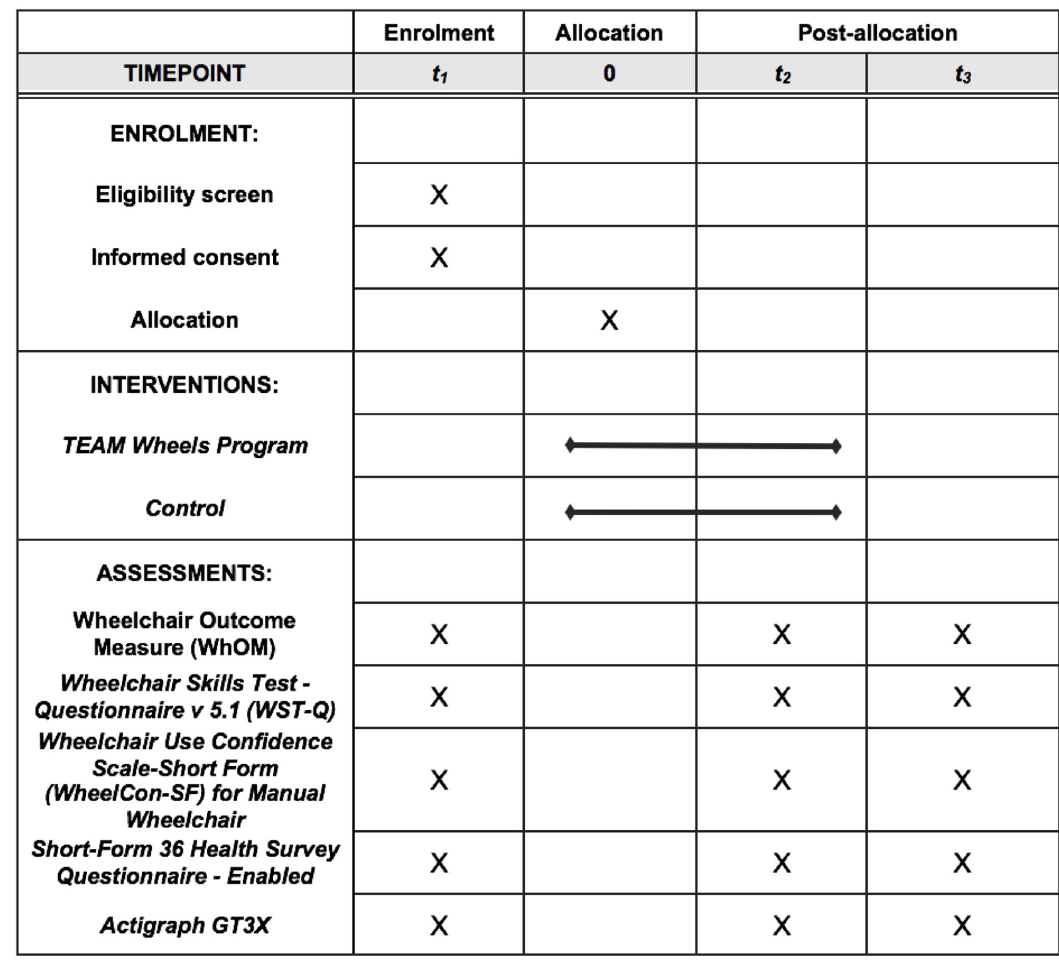
Fig 1. SPIRIT schedule of enrolment, interventions, and